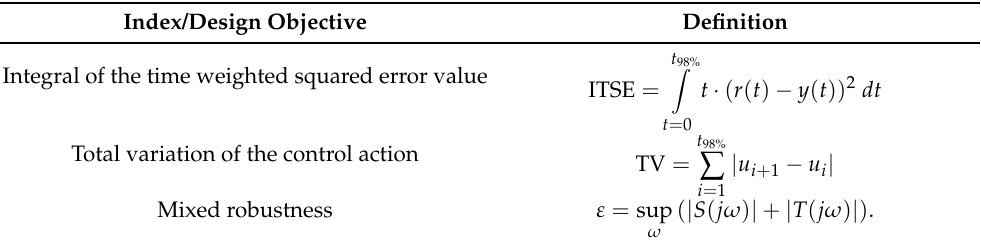
Table 1. Design objectives for the performance evaluation of the Linear ADRC (LADRC).